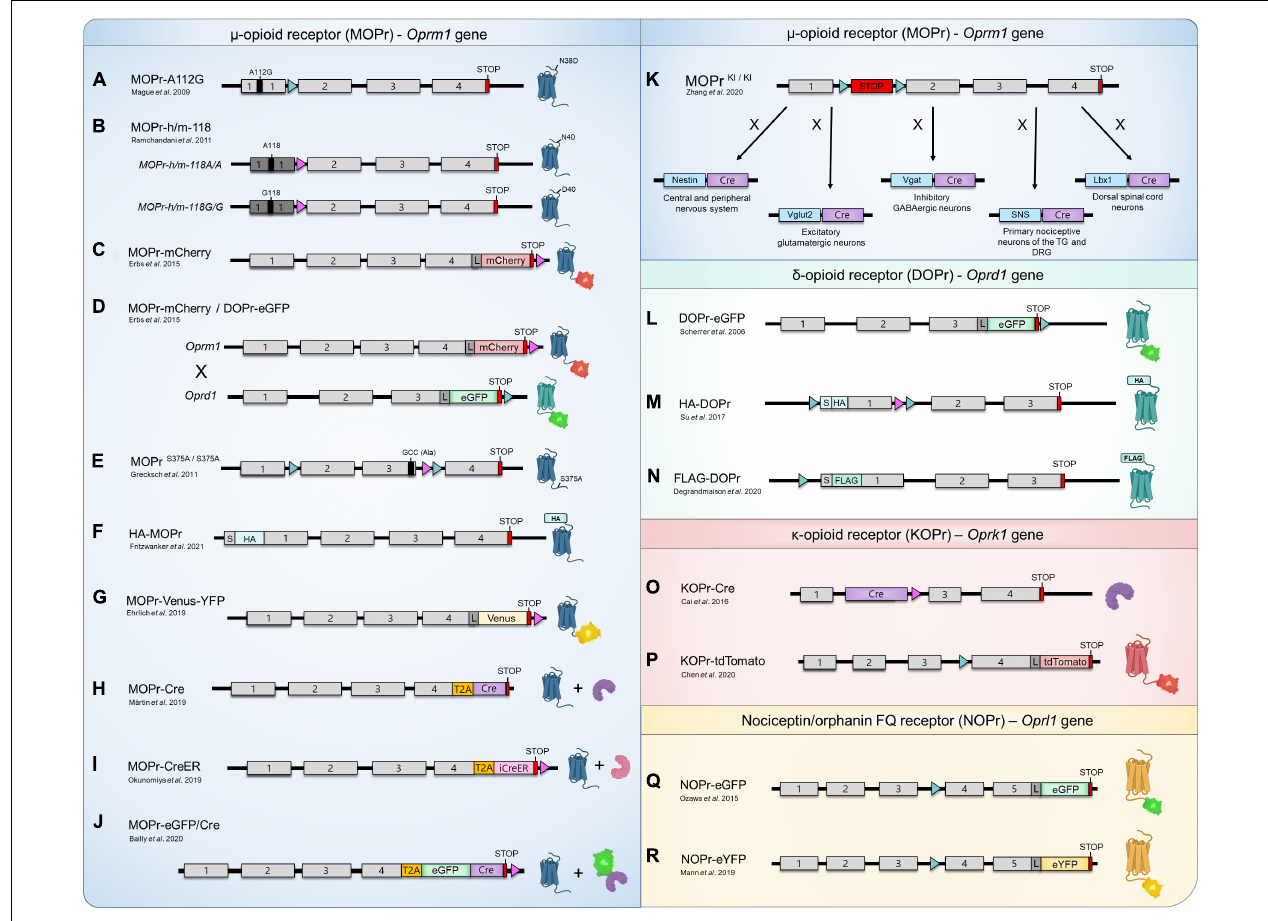
FIGURE 1 | Opioid and nociceptin receptors knock-in mouse lines. (A–R) Schematic representation of the design of currently available KI mouse models for the study of MOPr (blue), DOPr (green), KOPr (red), and NOPr (yellow). The sequence corresponding to the mouse (gray boxes) or human (dark gray boxes) exons, START codons (S), STOP codons (red boxes), loxP sites (aqua triangles), FRT sites (pink triangles), as well as the sequences encoding for various fluorescent proteins (eGFP, mCherry, tdTomato, Venus and eYFP), epitope-tag sequences (FLAG, HA), linker (L; encoding for Gly-Ser-Ile-Ala-Thr), Cre recombinase (Cre, purple boxes), inducible Cre recombinase-modified estrogen receptor (iCreeER, pink box) and the Thosea asigna virus 2A-like peptide (T2A, orange boxes) are identified. The schematic representation is not to scale. ( K ) Cre-mediated recombination can also occur in other regions than those